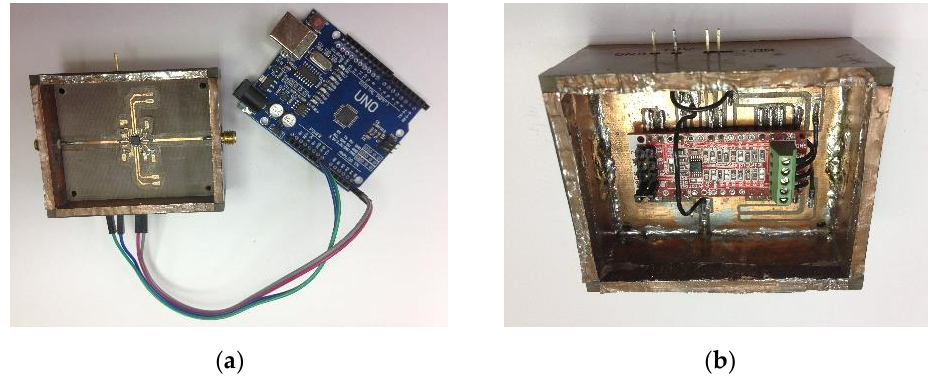
Figure 12. Comparison and acquisition circuit: ( a ) IQ-demodulator; ( b ) Analog-to-digital converter. The voltages V I and V Q are amplified and digitized by an ADS1115 analog-to-digital